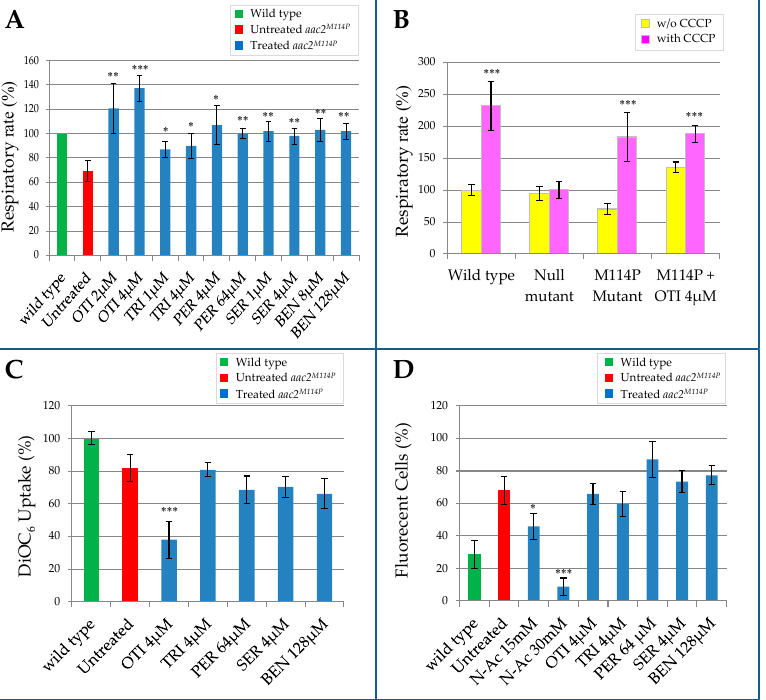
Figure 2. Effect of the identified drugs on WB-12/ aac2 M114P phenotypes. Wild type WB-12/ AAC2 , null mutant ( aac2 Δ ), and WB-12/ aac2 M114P mutant strains with or without the supplementation of active compounds were grown in YP medium supplemented with 0.6% glucose at 28 °C. ( A ) Oxygen con- sumption rate analysis. The highest and the lowest effective concentrations are reported for each molecule. Values were normalized to the values of the wild type strain and represented as the mean of at least four independent experiments ± SD. ( B ) Oxygen consumption rate under normal (yellow bars) and uncoupled state condition using the mitochondrial uncoupler CCCP (pink bars). Values were normalized to values of the wild type strain without CCCP and represented as the mean of three independent experiments ± SD ( C ) Mitochondrial membrane potential (MMP) was measured by the uptake of the fluorescent dye DiOC 6 . Values were normalized to the values of the wild type strain and represented as the mean of three independent experiments ± SD. ( D ) ROS production was determined as the percentage of fluorescent cells using DHR123 probe. In addition to the shown concentrations, halved concentrations were also tested, and similar results were obtained. The anti- oxidant agent N-acetyl-cysteine was used at two different concentrations (15 mM and 30 mM) as a positive control. All values are means of three independent experiments ± SD. Statistical analysis was performed using an unpaired, two-tailed Student’s t -test, comparing treated (blue bars) versus untreated (red bar) for ( A , C,D) , and comparing w/o CCCP (yellow bar) versus with CCCP (pink bar): * p < 0.05; ** p < 0.01; *** p < 0.001. The same amount of DMSO (compound vehicle) was added to the untreated mutant (red bar). OTI = otilonium bromide, PER = pergolide mesylate, TRI = trifluoperazine 2HCl, SER = sertraline HCl, BEN = benzydamine HCl.